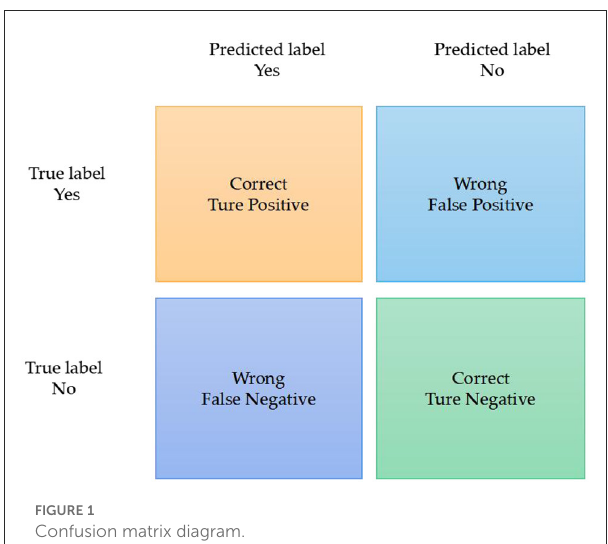
FIGURE1 Confusion matrix